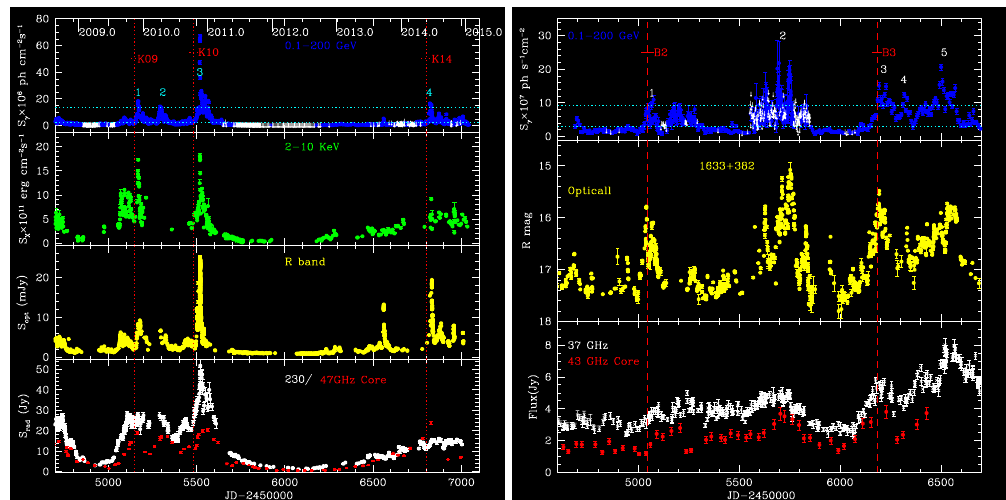
Figure 5. Left: The (top to bottom) γ -ray, X-ray, optical, and mm wave light curves of the quasar 3C454.3. The vertical red dashed lines show times of ejection of superluminal knots. The dotted cyan lines indicate the weighted mean γ -ray flux, (cid:104) S γ (cid:105) , and the level of (cid:104) S γ (cid:105) + 3 σ ; Right: The γ -ray (top), optical (middle), and mm wave (bottom) light curves of the quasar